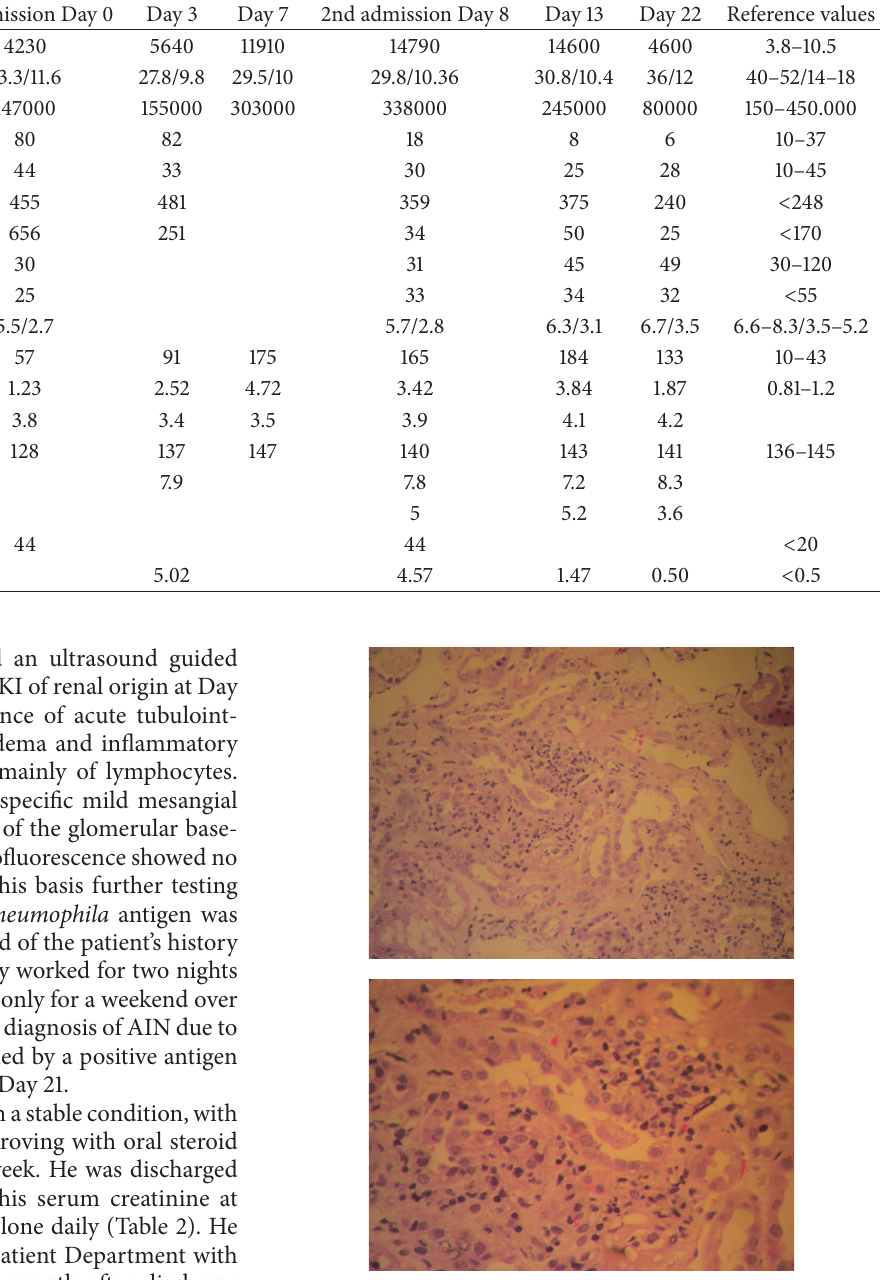
Figure 2: Renal biopsy: findings from light microscopy showing evidence of AIN with interstitial edema and inflammatory peritubu- lar infiltrations composed mainly of lymphocytes. The glomeruli have evidence of nonspecific mild mesangial enlargement, with no abnormalities of the glomerular basement